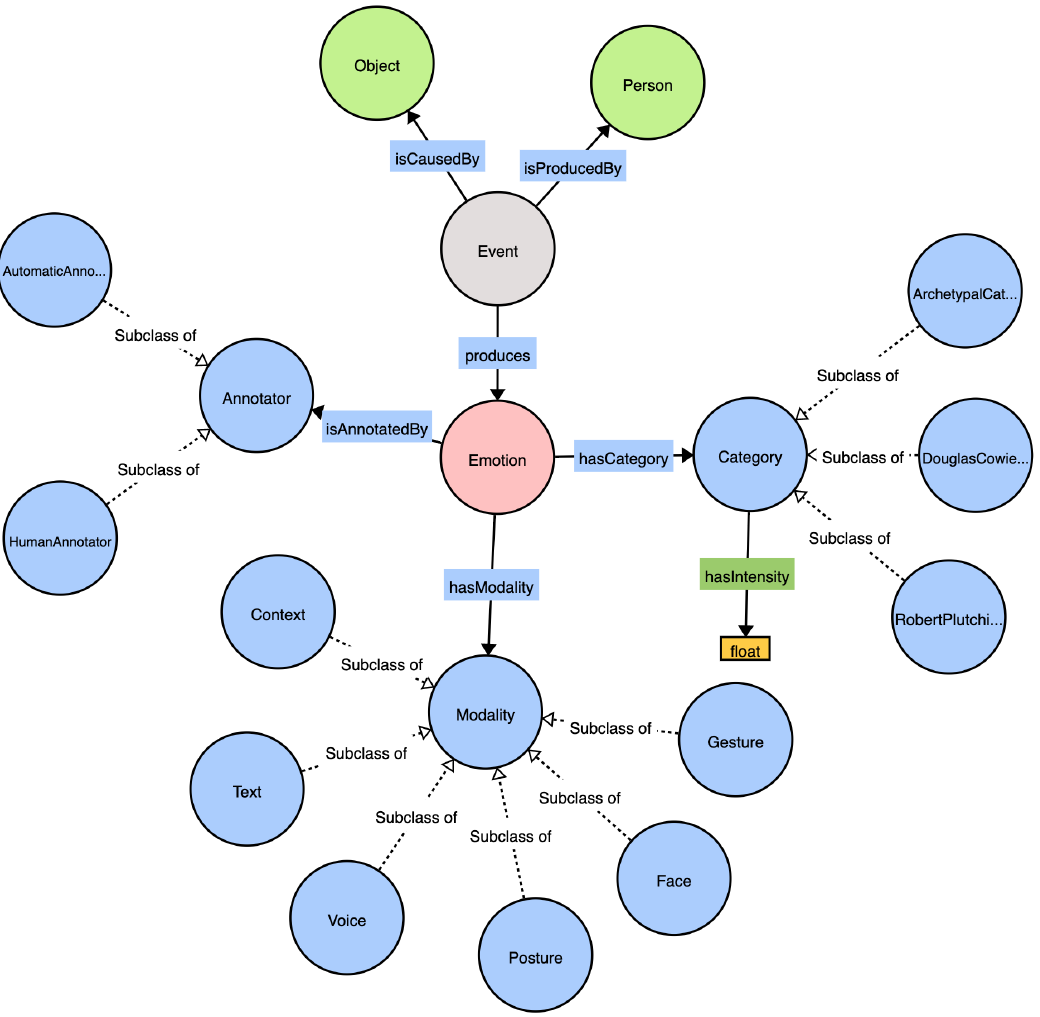
Figure 5. EMONTO: an extensible emotion